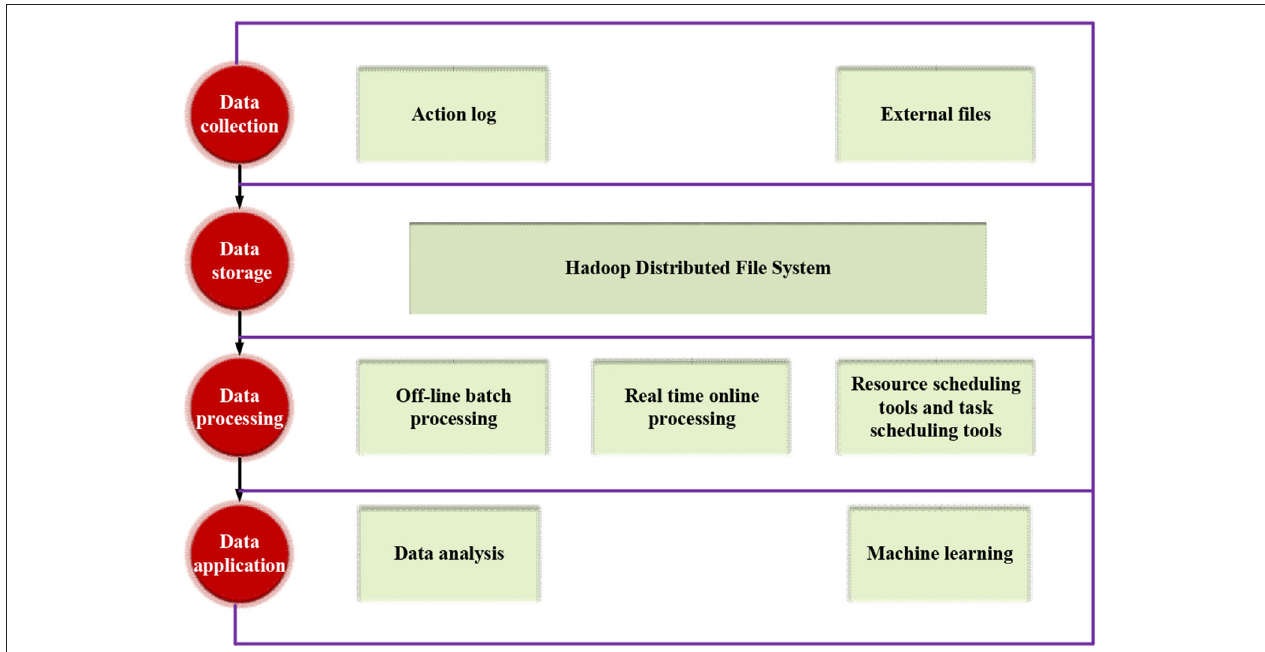
FIGURE 1 | Basic architecture of Big